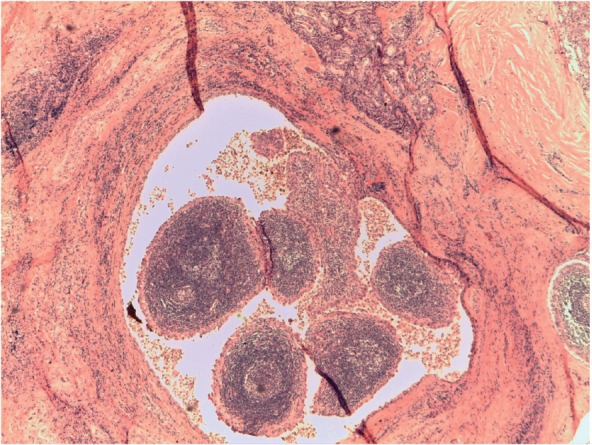
Papillary carcinoma Warthin-like x100 magnification.